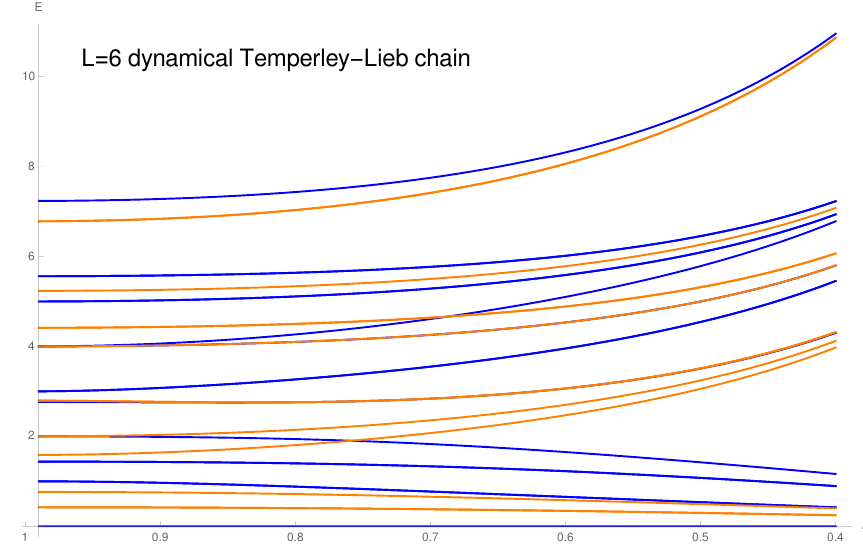
Figure 12 . The 2-magnon spectrum of the dynamical dilute Temperley-Lieb chain of the XZ sector for L = 6 , as a function of the deformation parameter κ . As discussed in the text, we can only have even numbers of magnons for even-length chains in this sector. Blue denotes untwisted sector energies while orange twisted sector energies. Note the degeneracies at E = 2 , 4 at the orbifold point κ = 1 , which get resolved as κ decreases from 1. We have plotted down to κ = 0 . 4 for clarity. As κ decreases further, the eigenvalues bunch into groups with limiting values of 4 /κ, 2 /κ and 0